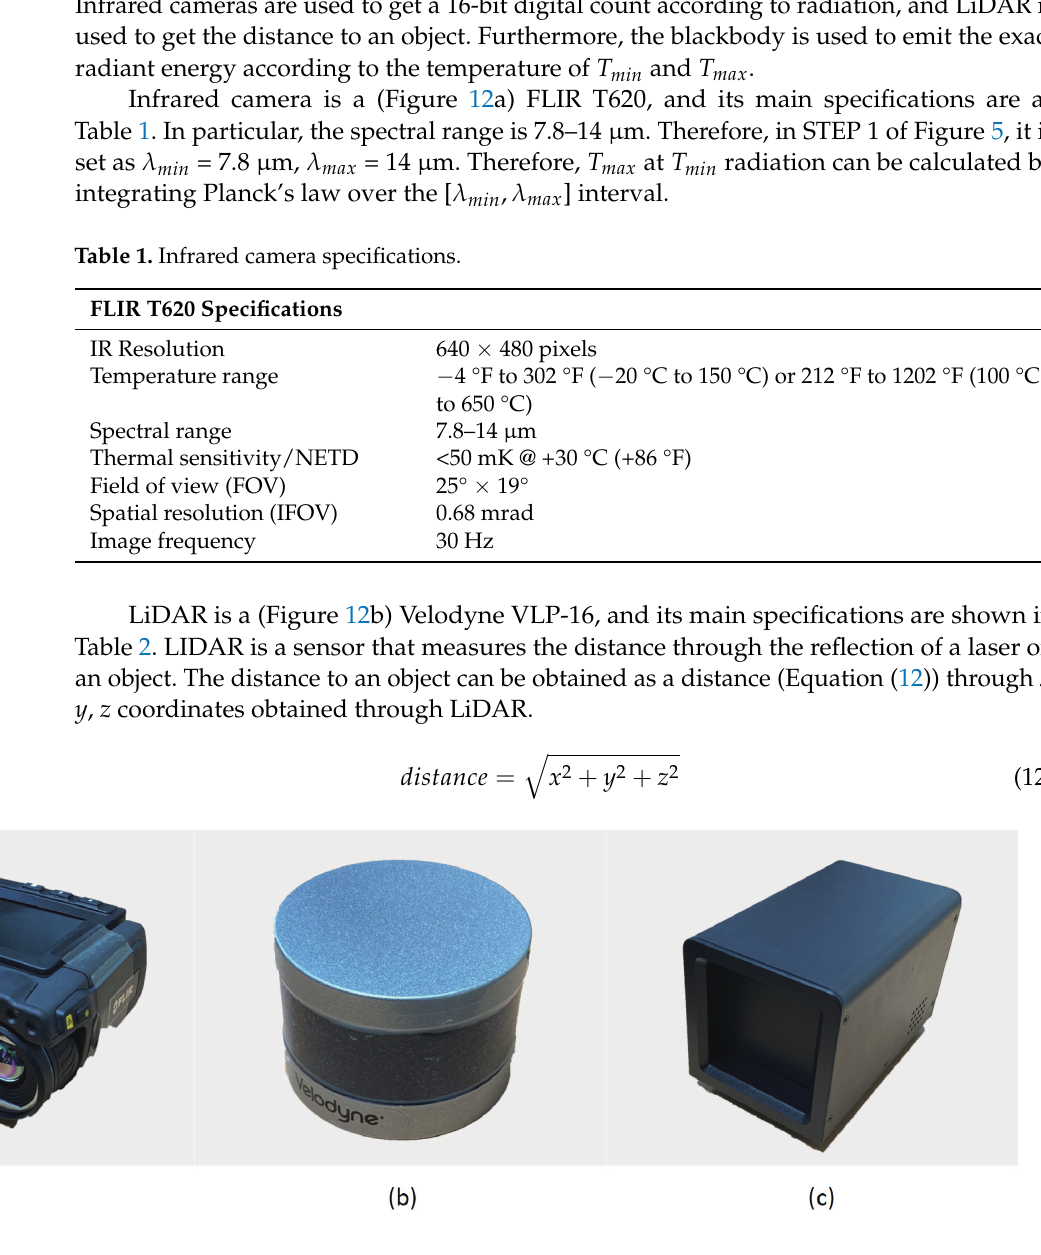
Figure 12. Experimental equipment: ( a ) Infrared camera (FLIR T620), ( b ) LiDAR (Velodyne VLP-16), ( c )